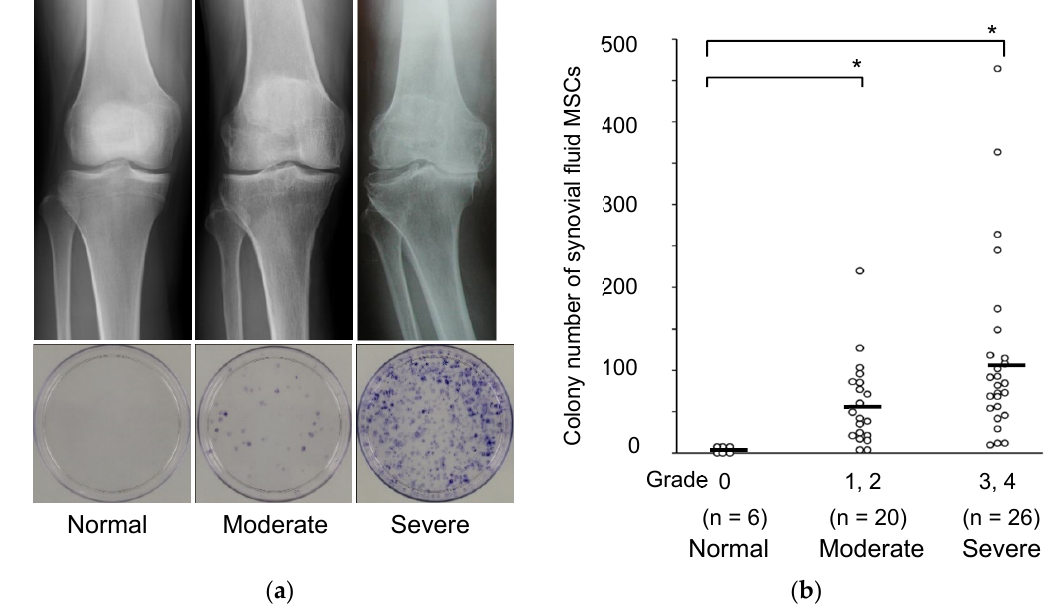
Figure 1. MSCs in synovial fluid derived from osteoarthritis patients by radiographic grade. ( a ) Radiographic images of the knees and representative dishes showing colonies of synovial fluid MSCs. ( b ) Relationship between the Kellgren–Lawrence grading and the colony number of synovial fluid MSCs per synovial fluid volume (mL). Average values are shown as bars ( * p < 0.05) (reproduced from [9]).